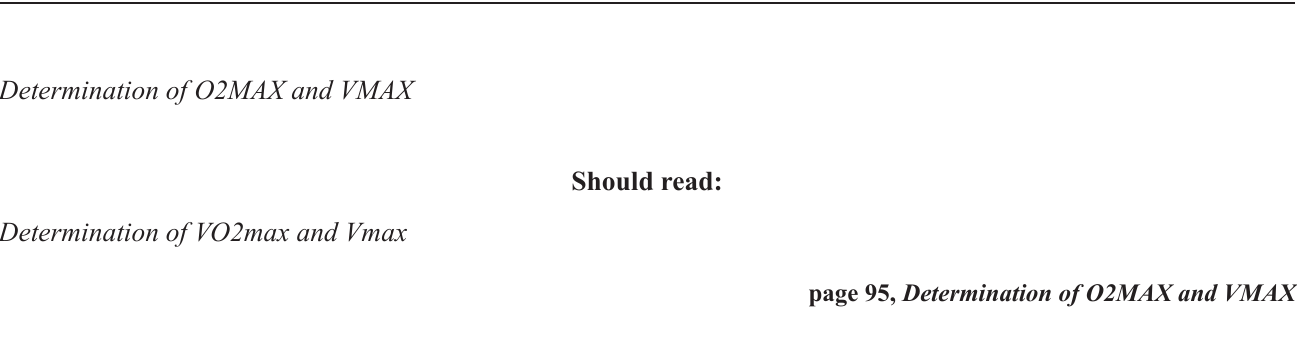
Figure 3. RAST test